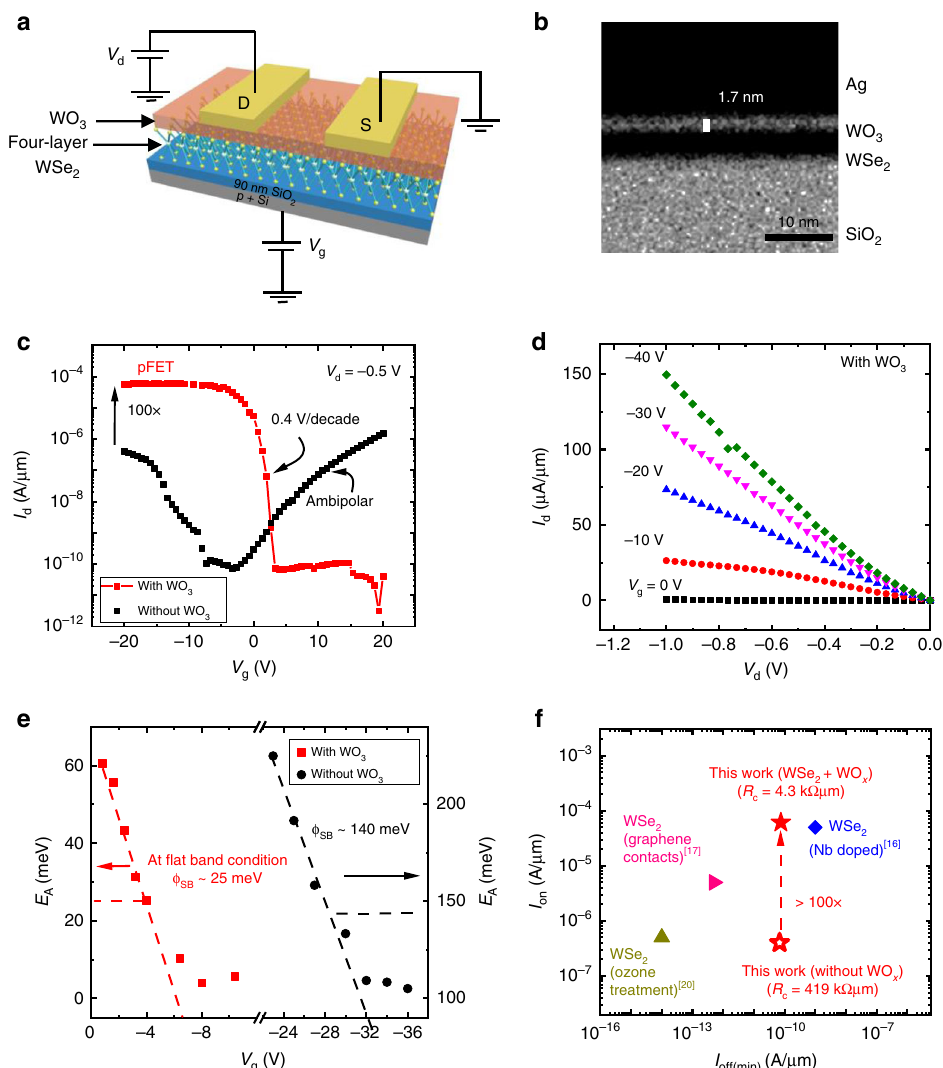
Fig. 2 Surface plasma-oxidized WSe 2 TFT and electrical characterization. a Device schematic showing a four-layer WSe 2 and 2.2 nm WO 3 on SiO 2 / p + Si layer with gate length ( L g ) = 1.80 µ m and width ( W ) = 2.05 µ m. b Transmission electron microscopy image of the device contact region, after post-contact plasma oxidation, revealing the presence of WO 3 underneath the metal contacts . c I d – V g plots for four-layer thick device with and without WO 3 . d I d – V d characteristics after plasma oxidation for different gate voltages. e Effective Schottky barrier height extraction from low-temperature transfer characteristics and Arrhenius plot. At fl at band condition, the curve deviates from linearity and the corresponding activation energy becomes the Schottky barrier. f Benchmark plot showing the performance of plasma-oxidized p -FET versus other reported data. I on is determined at V d = − 0.5